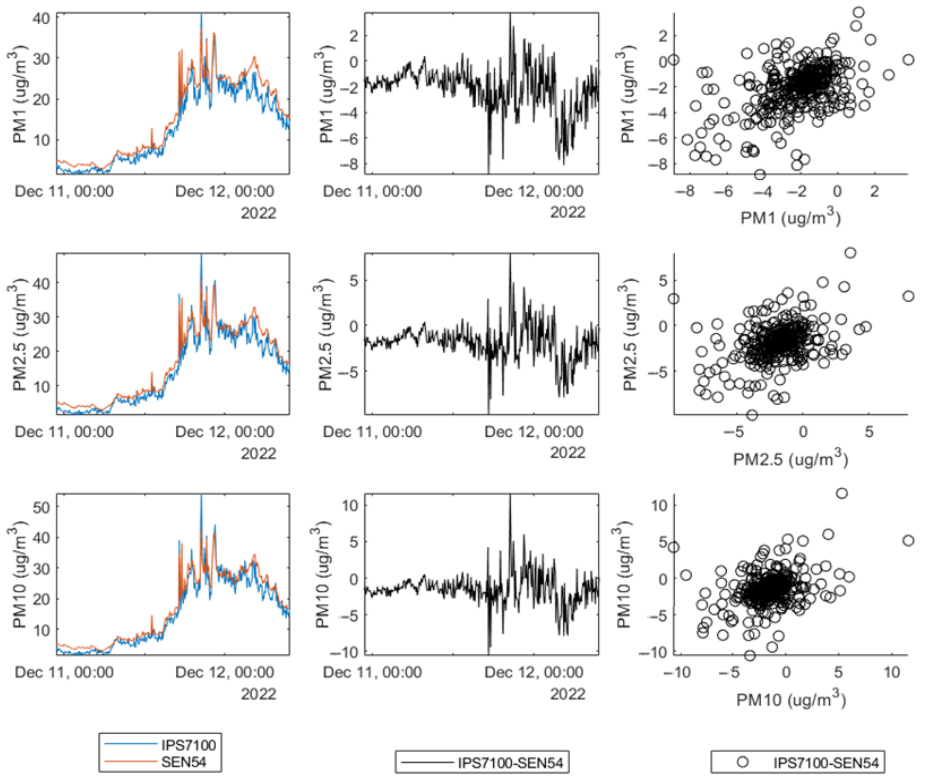
Figure 1. Comparison measurements for SEN54 sensors: mass concentration (first column) of PM1 (first row), PM2.5 (second row), and PM10 (third row) measured by IPS-7100 (blue) and SEN54 (red), the difference between the measurements (second column) and the scatter plot (third column), where the measurements are plotted on both x and y axes, while the y axis is shifted by one row relative to the x-axis.